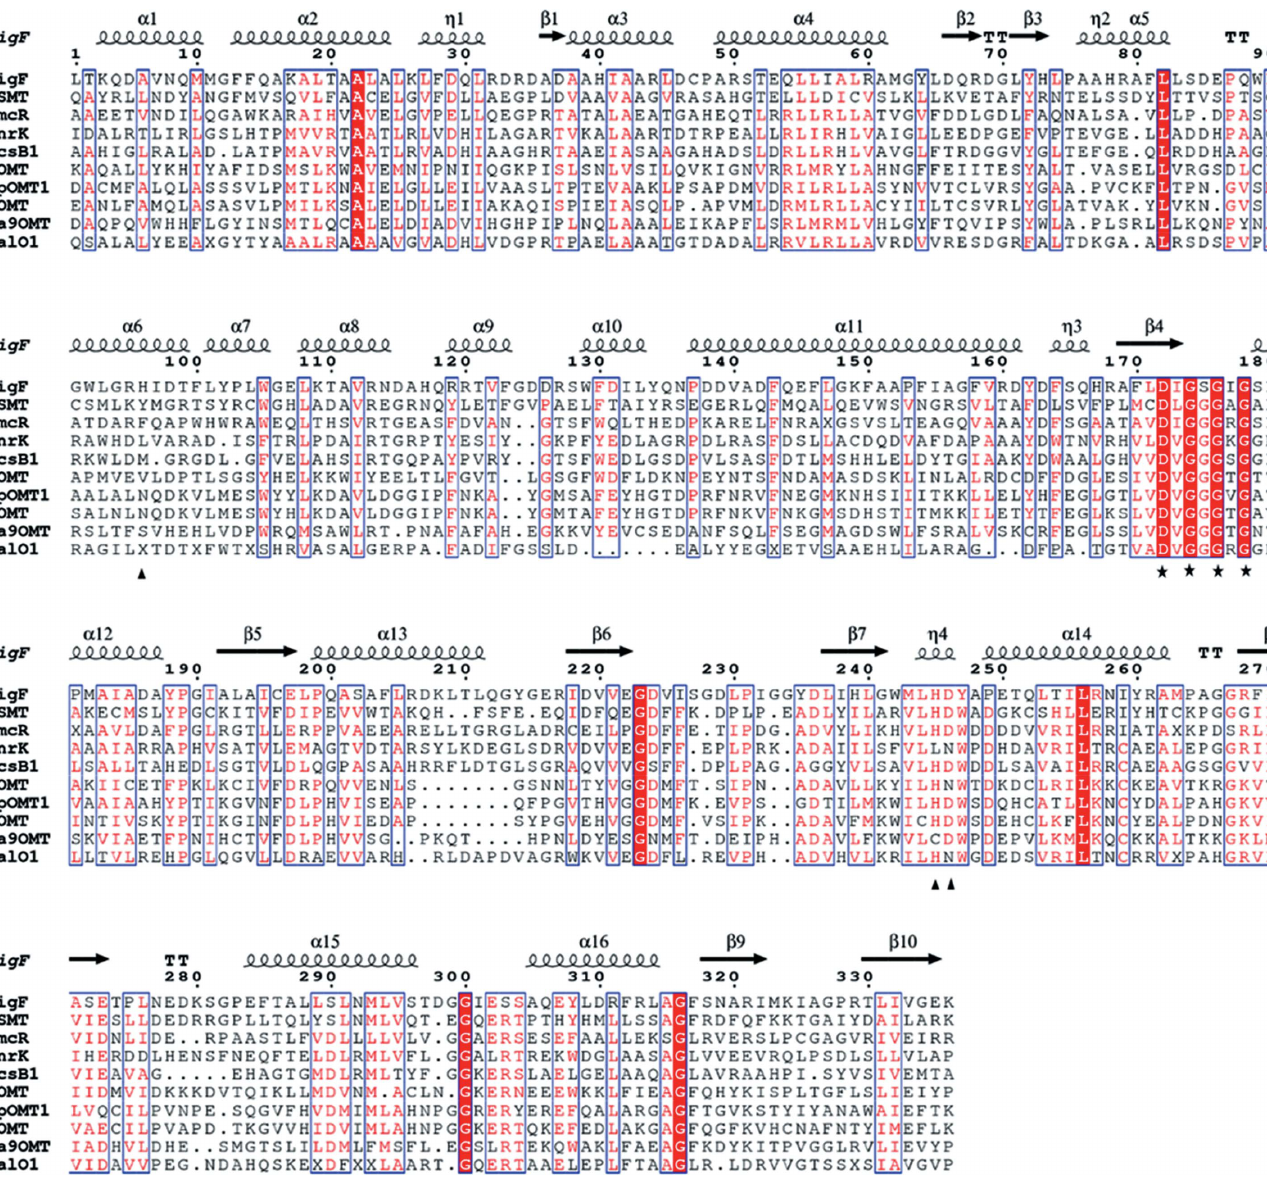
Figure 1 Sequence alignment of PigF with other methyltransferases. The conserved D X G X G X G motif is highlighted with a red background and is indicated by stars, conservatively substituted residues are boxed and His98, His247, Asp248 of PigF are indicated by triangles. The secondary structure of PigF is depicted above the